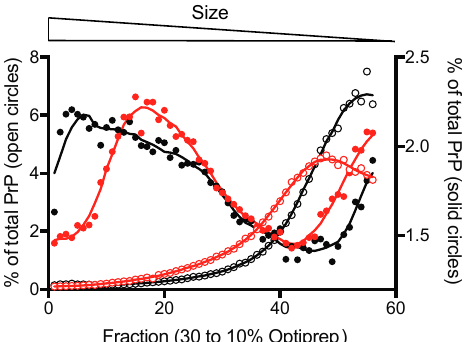
Figure 2. Pressure alters the size-distribution of PrP fibrils. Sedimentation velocity centrifugation in density gradients of mouse (black) and bank vole (red) PrP fibrils labelled with Alexa Fluor 488. The sedimentogram of non-treated fibrils is denoted in solid circles (right Y-axis) and those obtained after a cycle of compression (360 MPa)/decompression at 25 ◦ C are shown in open circles (right